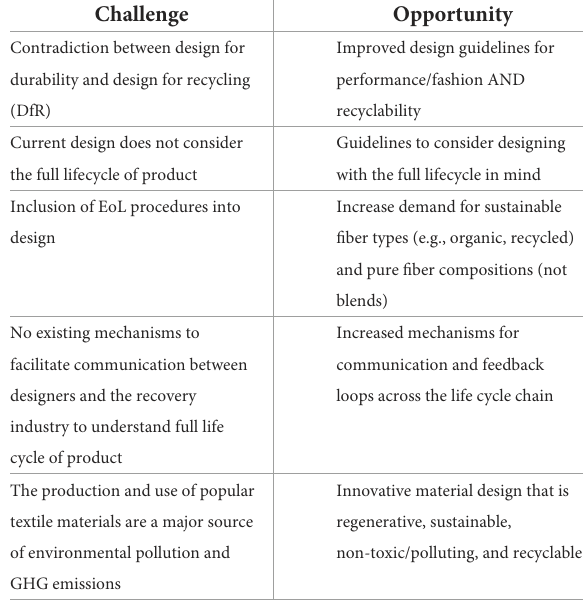
TABLE 5 Challenges and opportunities for labeling of textile products for circularity.